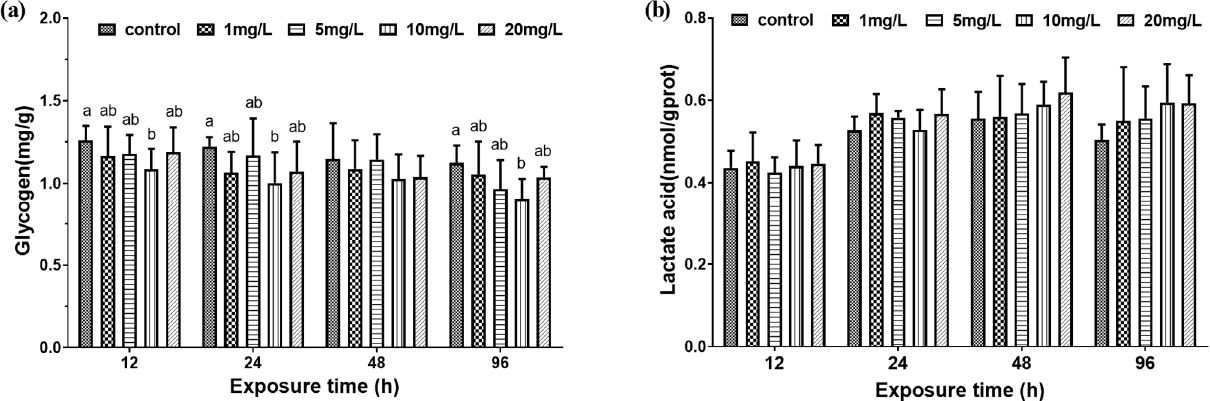
Figure 3. Concentration of muscle glycogen and lactate in M. amblycephala juveniles exposed to different nitrite concentrations from 12 h to 96 h. Data are expressed as mean ± SD (n = 3). ( a ) Muscle glycogen concentration; ( b ) lactic acid concentration. Different letters represent significant differences among treatments ( p < 0.05).